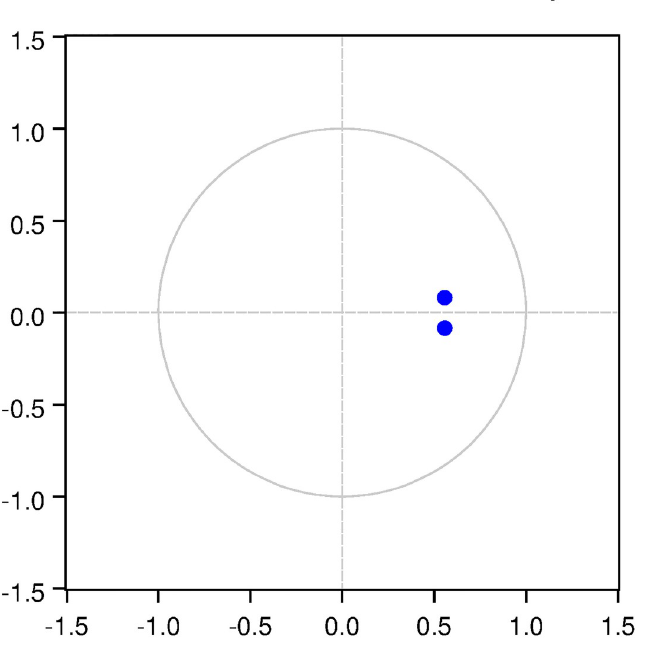
Fig 12. Inverse roots of AR characteristic polynomial for Korean data when P = 1 (Fisherian model).